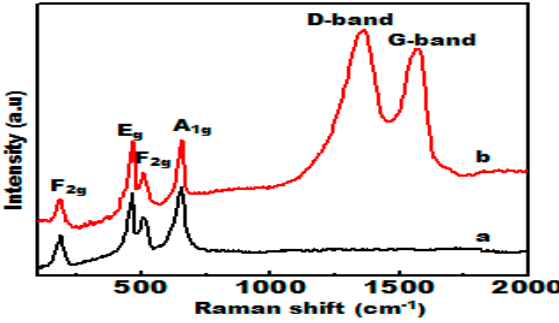
Figure 4. Raman spectra of ( a ) NiCo 2 O 4 nanofibers and ( b ) C/NiCo 2 O 4 hybrid nanofibers.